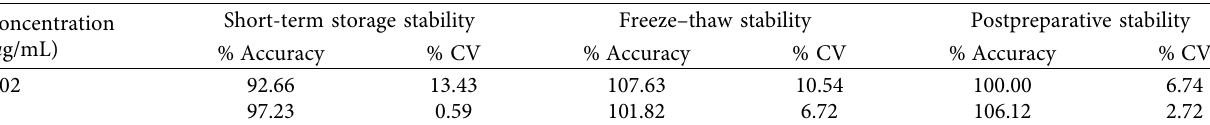
Table 2: Stability of the proposed method for determining gemifoxacin levels in human plasma samples ( n � 3). Short-term storage stability Freeze–thaw stability Postpreparative Concentration ( μ g/mL)